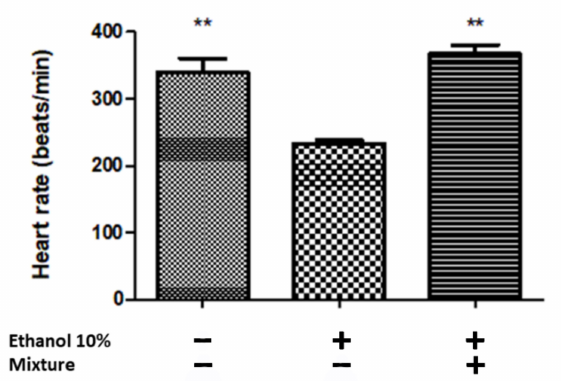
Figure 6. Effects induced by the mixture (2 mg/mL) on heart rate in the Daphnia magna toxicity model. ANOVA, p < 0.001; ** p < 0.01 vs. EtOH 10%, this last representing the positive control toxicity